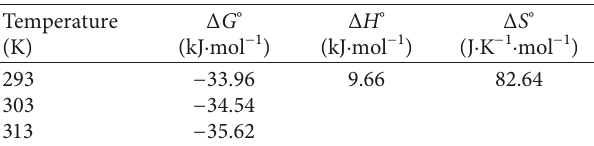
Table 7: Thermodynamic parameters for MB adsorption on op- timal activated carbon.